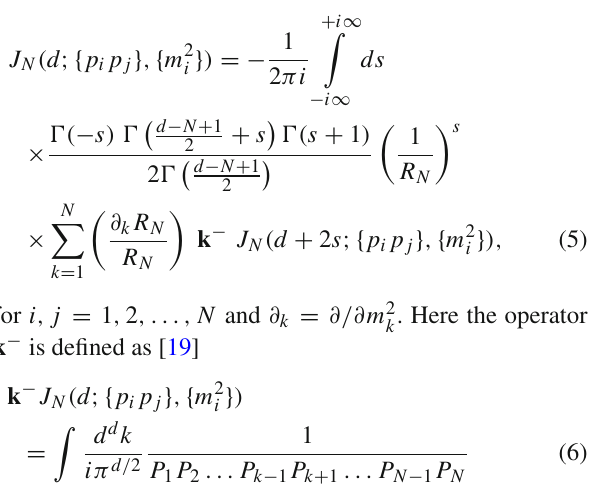
description for this method can be found in Ref. [19].